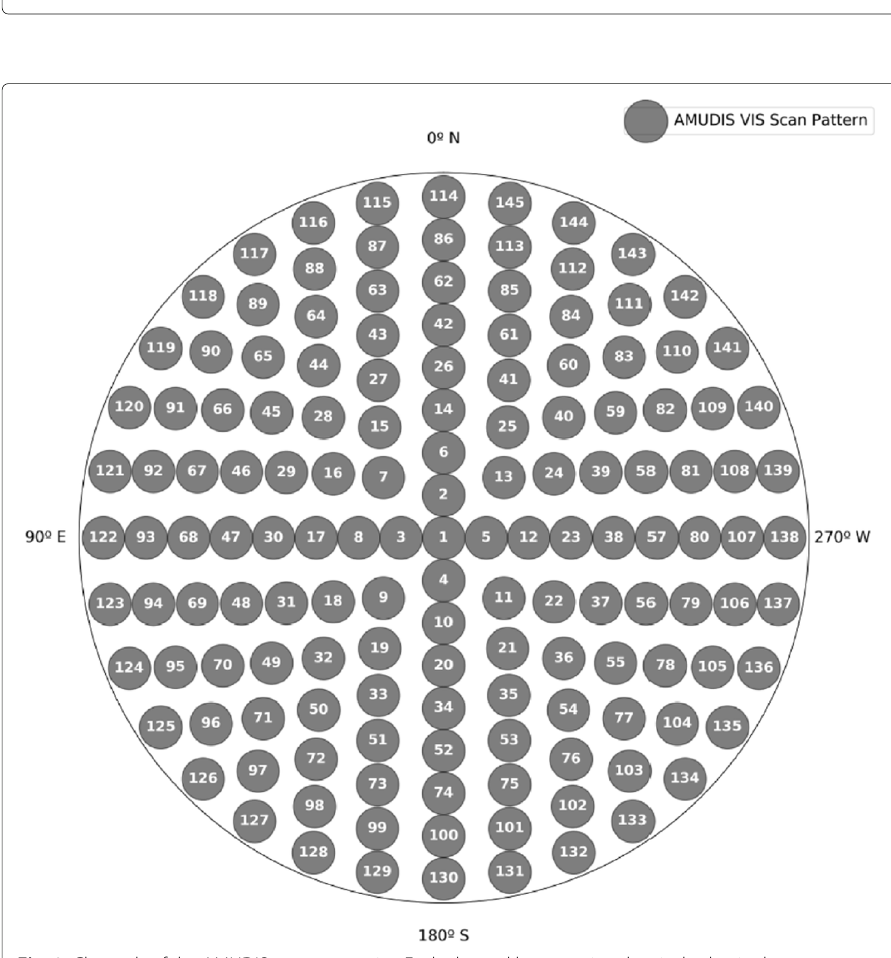
Fig. 1 Scheme of the multi-directional entrance optics (MDIO) of AMUDIS system. 435 optical fibres are distributed on the dome pointing at 145 different directions of the sky. At the end of the optical fibre bundle. the fibres are vertically aligned on a slit which can be connected to the spectroradiometer